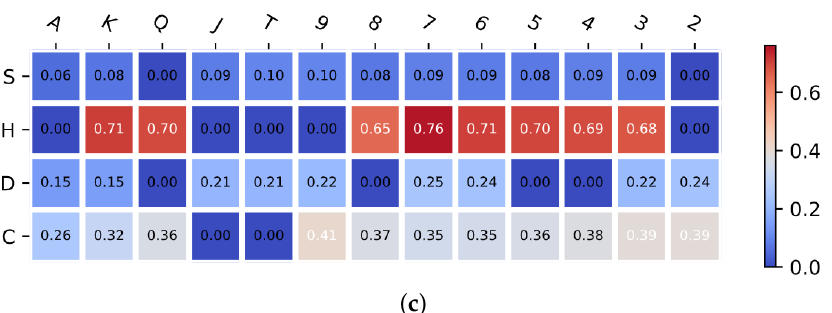
Figure 10. The visualization system. ( a ) Average HCPs of North player; ( b ) The distribution of the number of cards in different suits of West players; ( c ) The distribution of West player’s hands. We show the hands distribution in the form of a heat map. The horizontal axis of the heat map represents the size of the cards, and the vertical axis represents the suit of the cards. The darker the color, the higher the probability of owning the card in hand. It is evident that the West player has more cards in the suit of H( ♥ ).